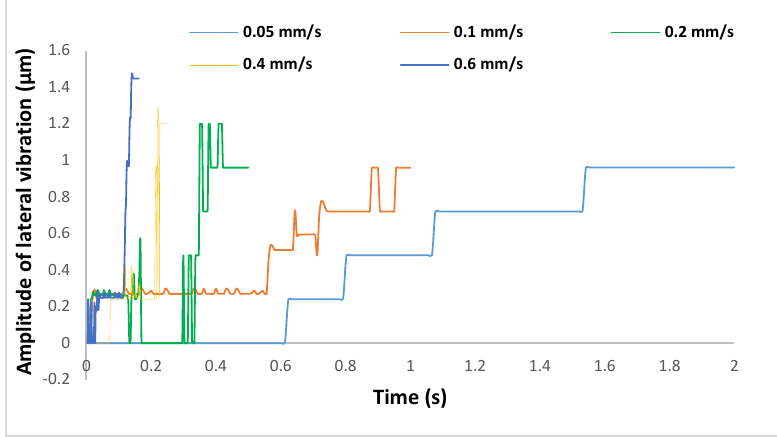
Figure 12. The effect of egg-injection speed on vibration creation.